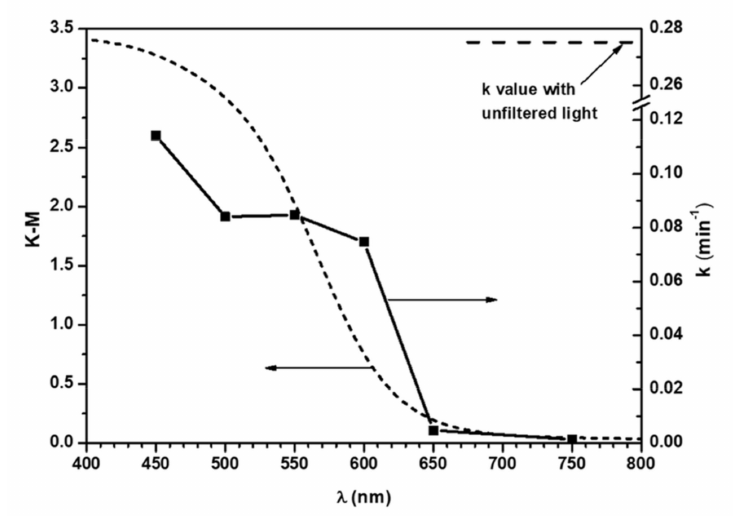
Figure 4. Spectral response of the initial RhB dye degradation (Adapted from Ref.